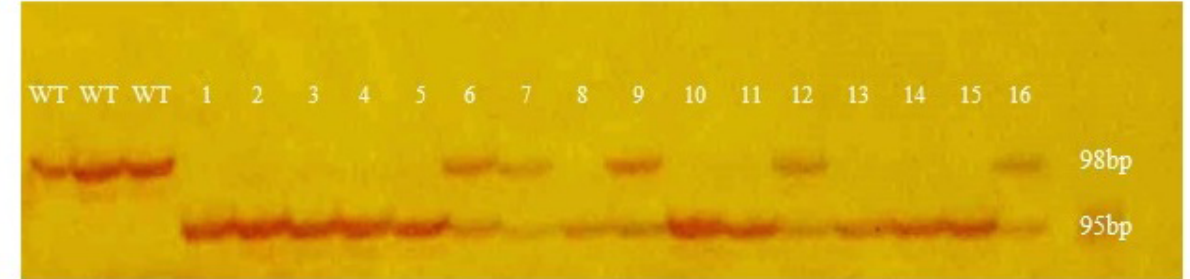
Figure 1. Detection of the F508del mutation by PCR on a 6% polyacrylamide gel. WT: positive non-carrier controls (two 98bp fragments). Lanes 1, 2, 3, 4, 5, 8, 10, 11, 13,14 and 15 are homozygous patients for the variant (two 95bp fragments). Lanes 6, 7, 9, 12 and 16 are heterozygous patients for the variant (one 95bp and one 98bp fragment). MWM: 25 bp molecular weight marker. Table 1. Age, sex and genotype of CF patients included in the study. Age